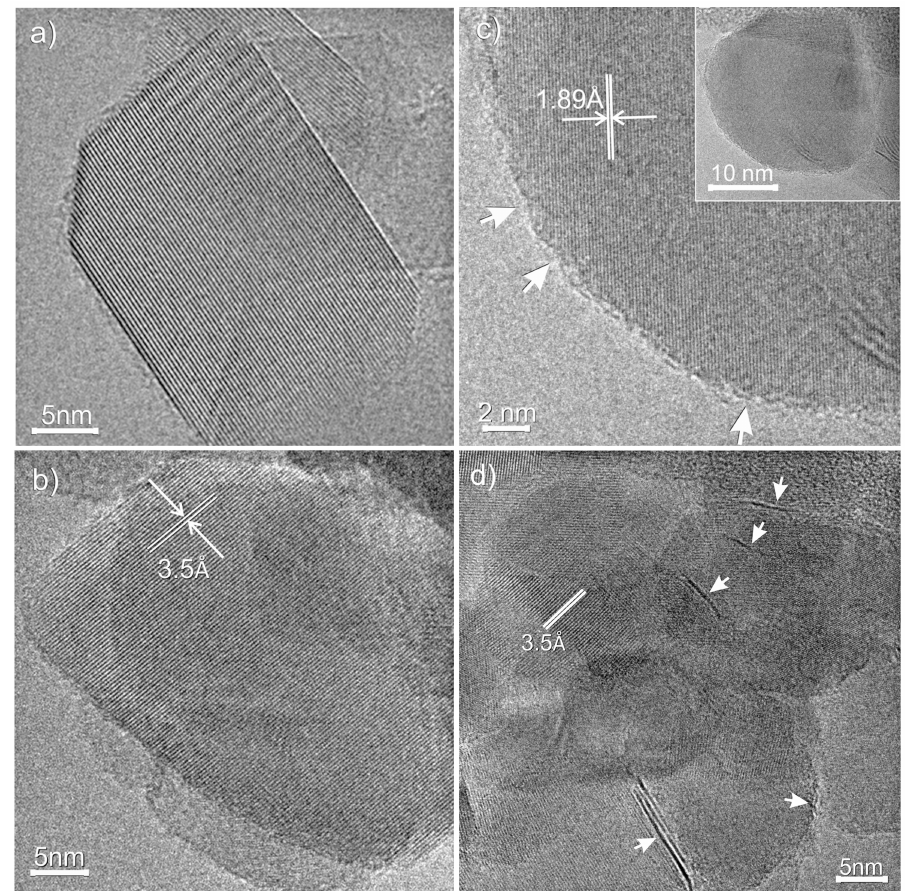
Figure 1. HRTEM images of ( a ) TiO 2 P25, ( b ) sulfided-TiO 2 and ( c , d ) MoS 2 /TiO 2 (Mo 3 wt %). The arrows in ( c ) indicate local erosions on TiO 2